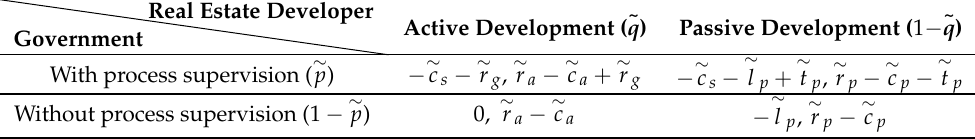
Table 2. Triangular fuzzy profit and loss value matrix of mixed game strategy between government and real estate